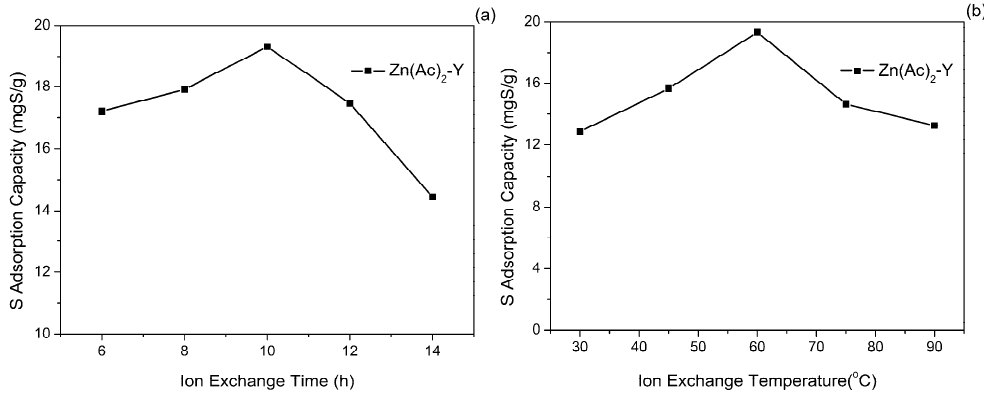
Figure 5. Effect of ( a ) ion-exchange time and ( b ) ion-exchange temperature on sulfur adsorption capacity (initial sulfur concentration: 1000 ppmw, T = 40 °C, t = 2 h, adsorbent dosage = 20 g/L).